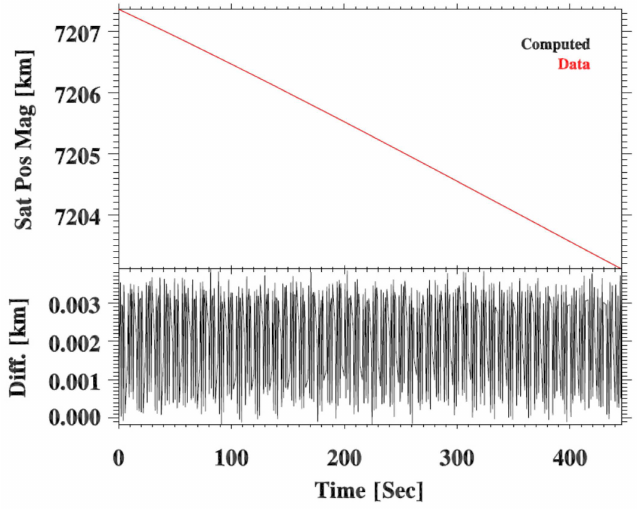
Figure 6. ( Top ) Magnitudes from satellite position vectors in ECEF contained in CrIS geolocation datasets (red color) and derived from Equation (2) (black) as well as their differences ( bottom